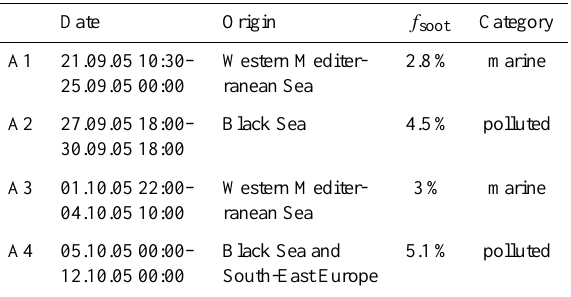
Table 1. Air mass definitions, based on the mass fraction of soot (EC) f soot is in particles < 1µm based on SDI chemical